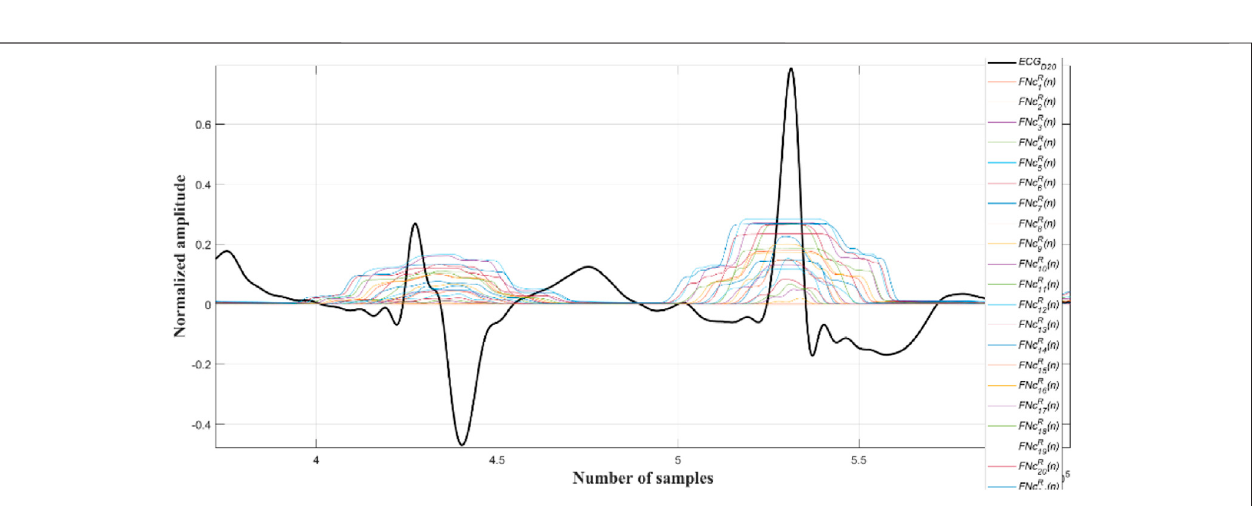
FIGURE 5 | ECG D 20 ; record # 104m, MITDB, and FNc R q ( n ) ( q ϵ [ 1 , 21 ])